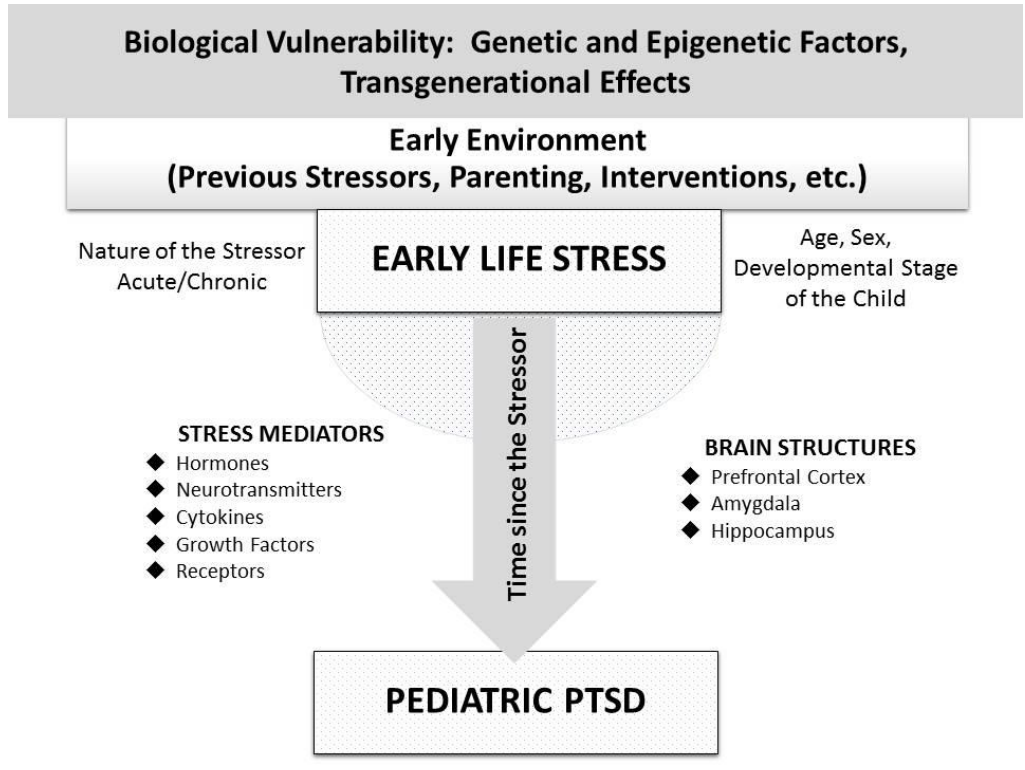
Figure 1. Parameters affecting the neurobiological trajectories from early-life stress to pediatric PTSD .